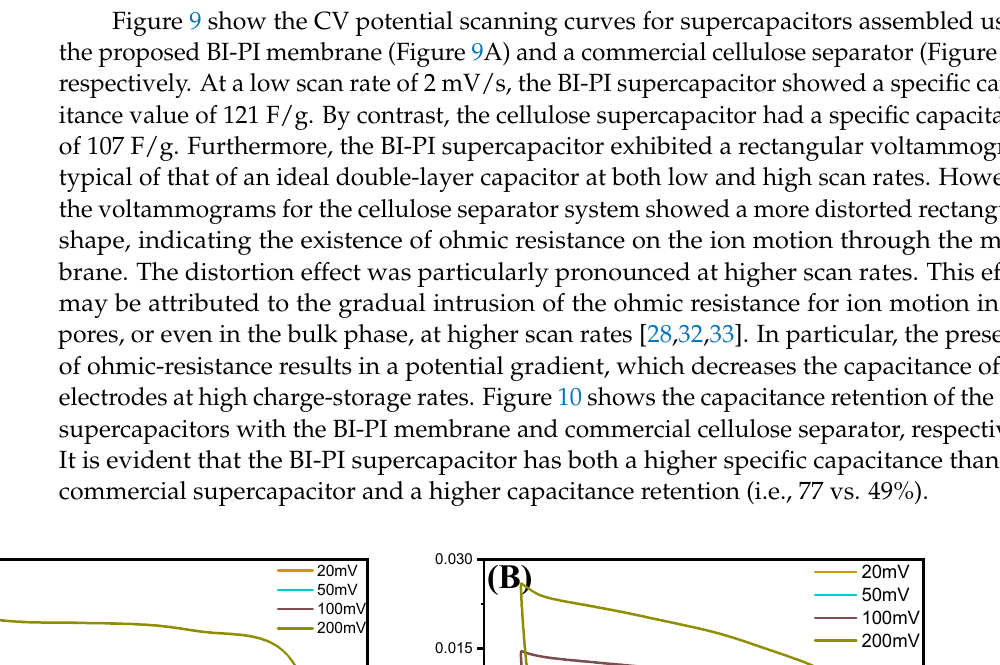
Figure 10. Specific c apacitance and capacitance retention vs. scan rate for ( A ) hot-pressed BI-PI ca- pacitor and ( B ) commercial TF-4030 cellulose capacitor. Figure 11 shows the Nyquist-type impedance spectra of the BI-PI supercapacitor and cellulose supercapacitor, respectively. The real-part resistance in the high-frequency re- gion comprises both the equivalent series resistance (R s ) of the supercapacitor (attributed to the resistance of the electrolyte and the separator) and the interfacial resistance (R ct ) of the supercapacitor [15]. The full-scale spectra in Figure 11 have the form of almost vertical lines, indicating that both cells have a good capacitive performance. In general, a higher slope of the Nyquist plot indicates a lower impedance of ion conduction within the system [15]. Thus, the results indicate that the BI-PI supercapacitor has a lower Rs resistance than the cellulose supercapacitor. The interfacial resistance, R ct , of a supercapacitor is associ- ated with the resistance created by ion migration in the carbon electrode and separator region, respectively [15]. The BI-PI capacitor and cellulose capacitor have R ct values of 3.14 and 3.53 Ω , respectively, as determined by the impedance spectra. Overall, the results show that the BI-PI capacitor has both a small R ct value and a low R s resistance, and thus provides an extraordinarily fast charge − discharge performance.